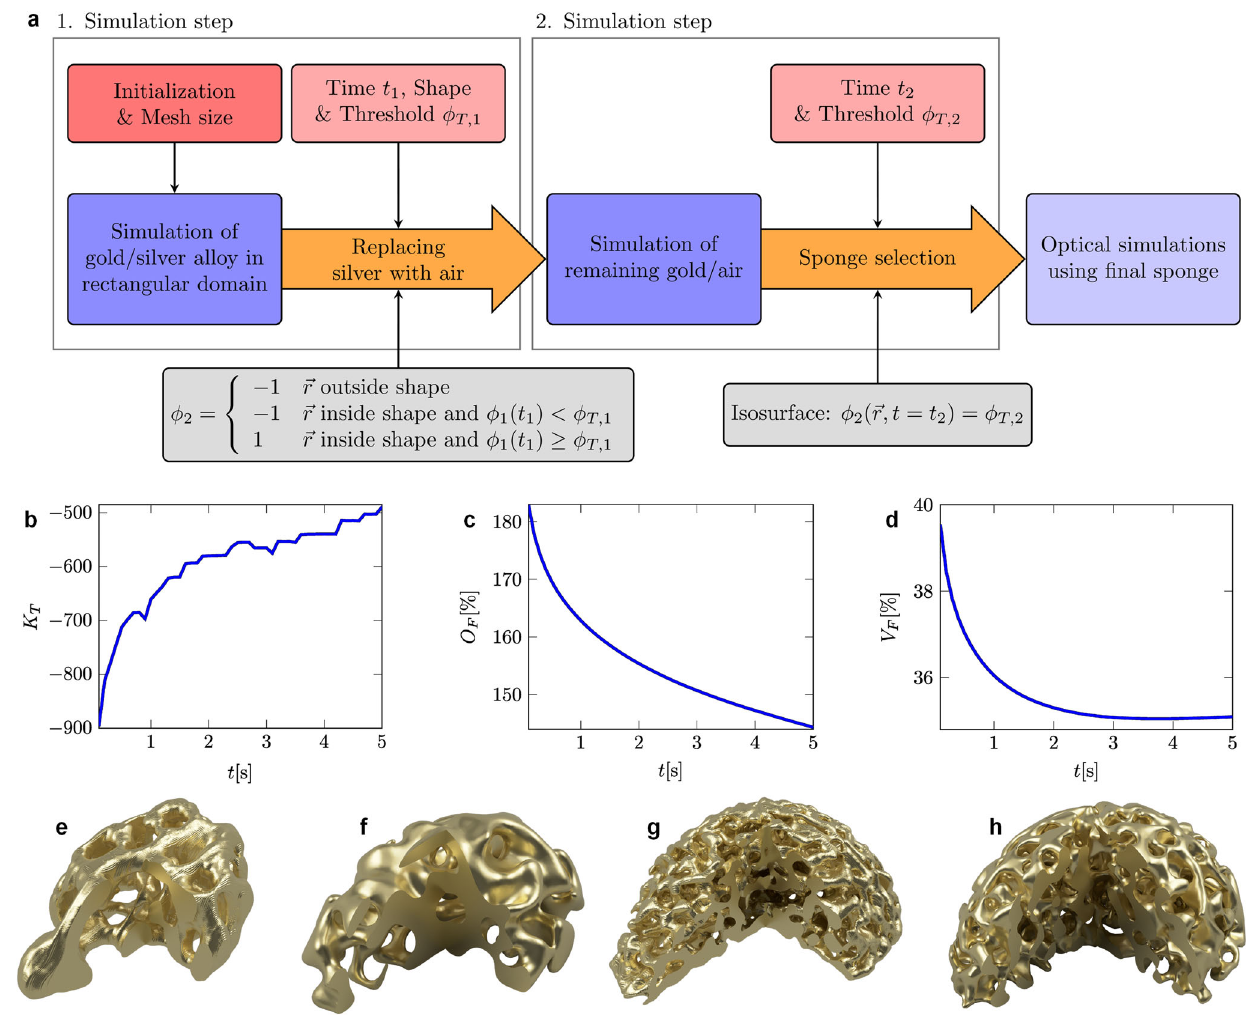
Fig. 3 Illustration of the nanosponge geometry creating algorithm. a Schematic representation of the simulation process. b – d Evolution of morphological signatures of the coarse-pored sponge S c ,1 during second phase- fi eld simulation; Integrated Gaussian curvature K T , proportional to the number of pores; Surface fraction O F ; Volume fraction V F . e – h Three-dimensional rendered images of experimentally measured and of simulated sponge geometries; measured coarse-pored reference sponge after smoothing; simulated coarse-pored sponge S c ,2 ; measured fi ne-pored reference sponge after smoothing; simulated fi ne-pored sponge S f ,1